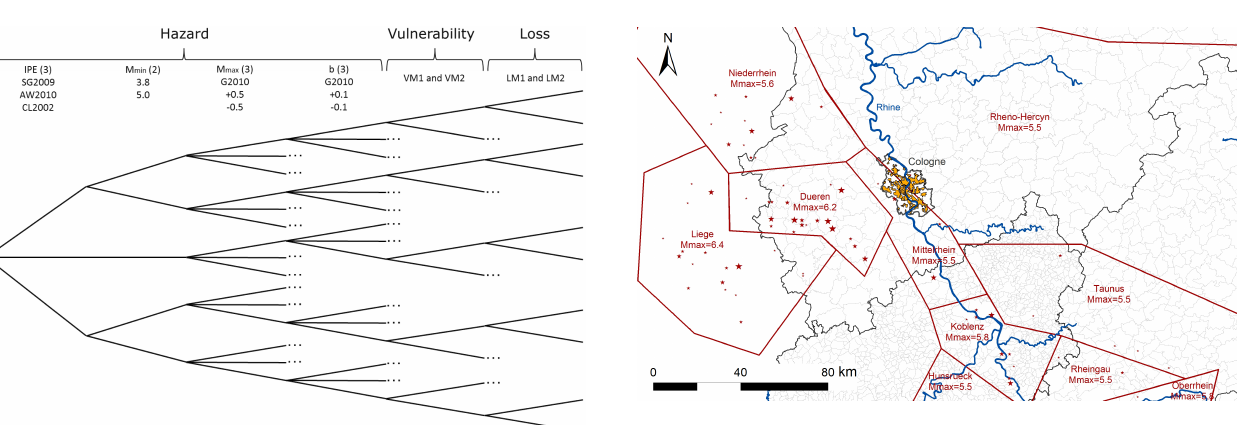
Figure 2. Seismic source zones (SSZ) around Cologne (according to Grünthal et al., 2010). The stars show the epicentres of past earthquakes in the area (from the CENEC earthquake catalogue, Grünthal et al., 2009). The grey lines show the administrative boundaries. The built-up area in Cologne is shown in yellow.